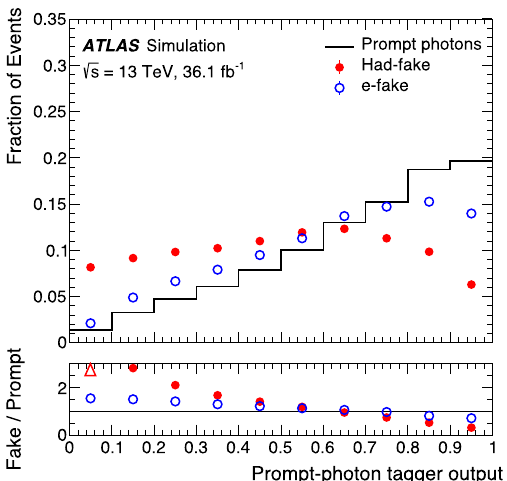
Fig. 13 The simulated shapes of the output of the prompt-photon tag- gerfortheprompt,hadronic-fake,andelectron-fakephotonsafterapply- ing Tight identification and isolation